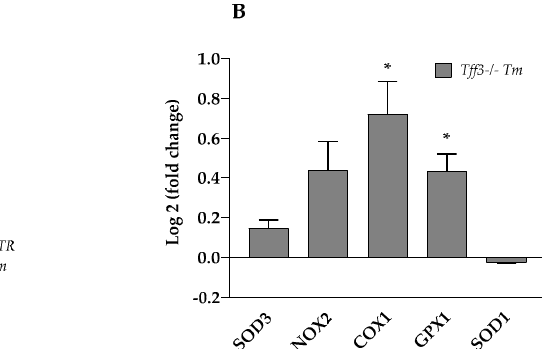
Figure 3. Effect of tunicamycin treatment on the expression of relevant oxidative stress genes in Wt- and Tff3 -deficient mice. We performed qPCR using SYBR green detection for each group ( n = 5 animals per group), Ct data were analyzed by the REST program and presented relative to Wt control ( A ). Expression of genes in tunicamycin-treated Tff3 -deficient mice was expressed relative to Wt tunicamycin-treated mice ( B ). * p ≤ 0.05; Wt Tm = wild type tunicamycin-treated mice, Tff3 − / − CTR = Tff3 deficient untreated mice, Tff3 − / − Tm = Tff3 − / − tunicamycin-treated mice.